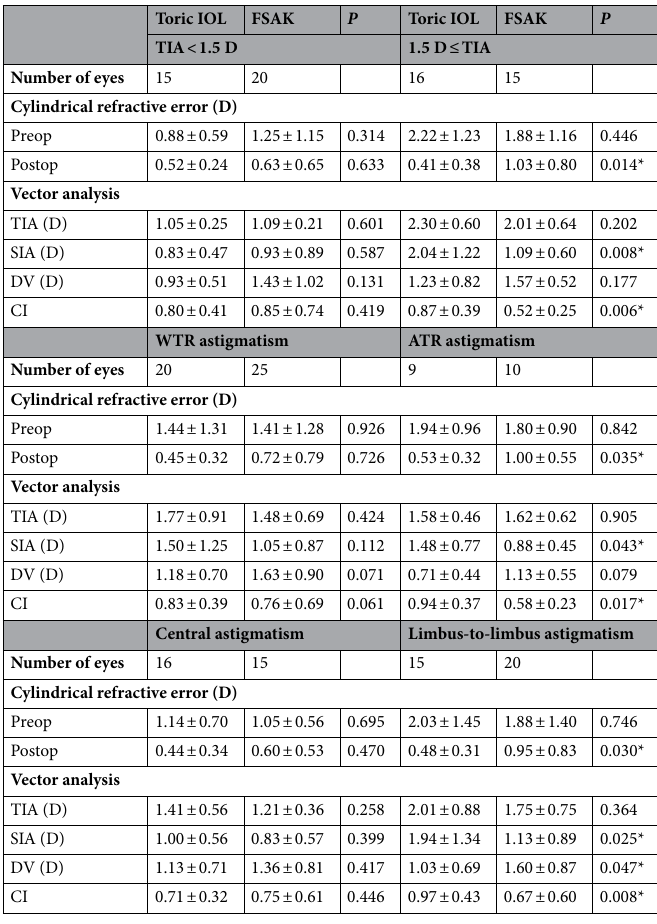
Table 3. Subgroup analysis of postoperative changes in refractive astigmatism. TIA target-induced astigmatism, D diopter, SIA surgically induced astigmatism, DV difference vector, CI correction index, WTR within-the-rule, ATR